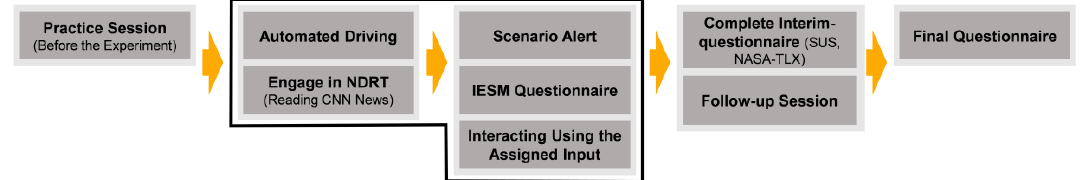
Figure 3. Experiment flowchart.